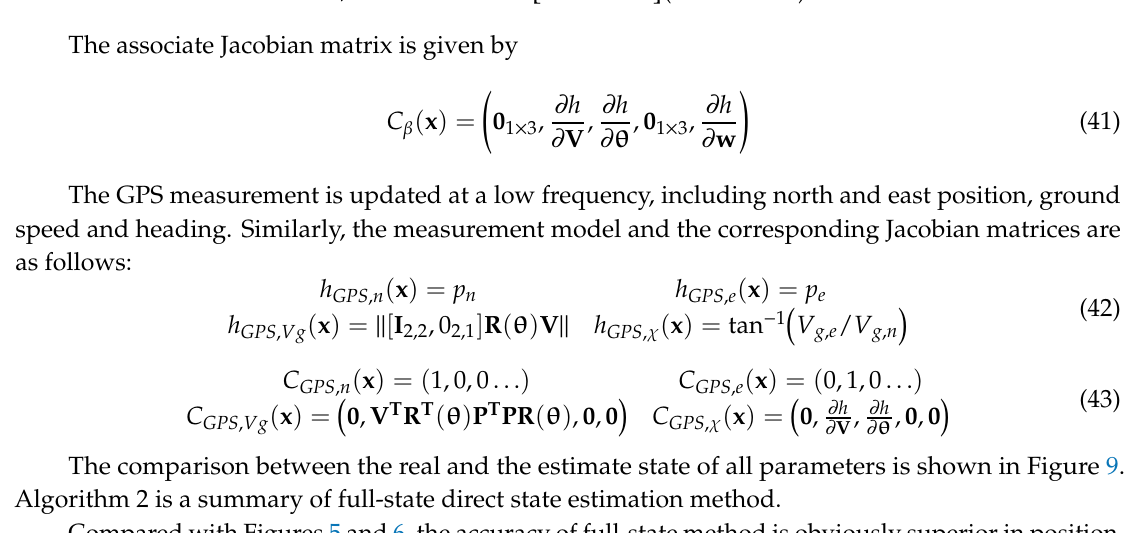
Algorithm 2 is a summary of full-state direct state estimation